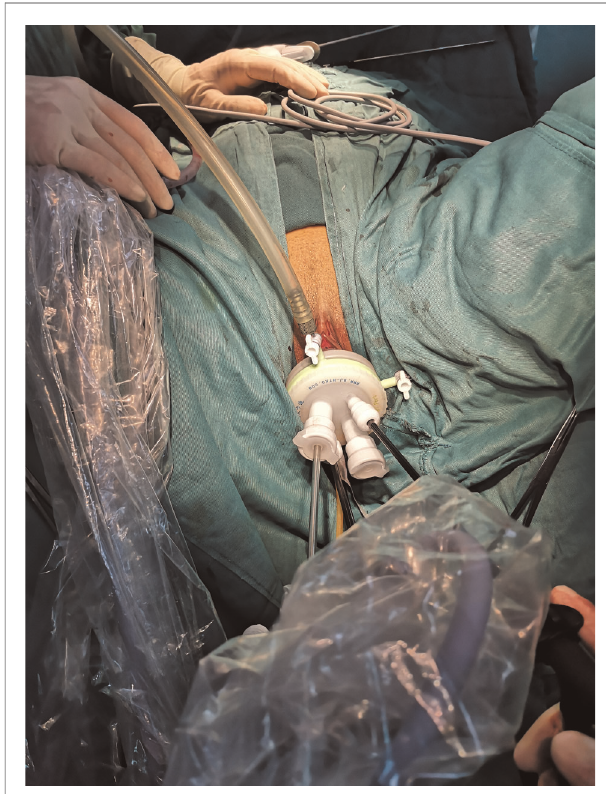
FIGURE 2 | Schematic diagram of laparoscopic operation devices.